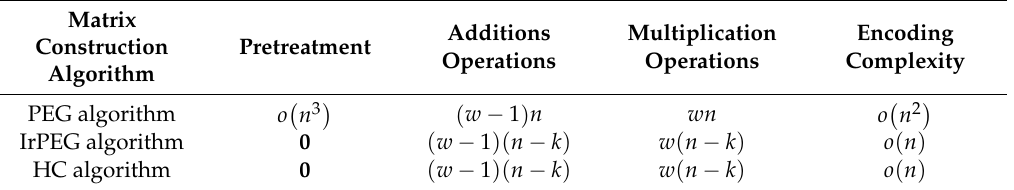
Table 4. Encoding complexity